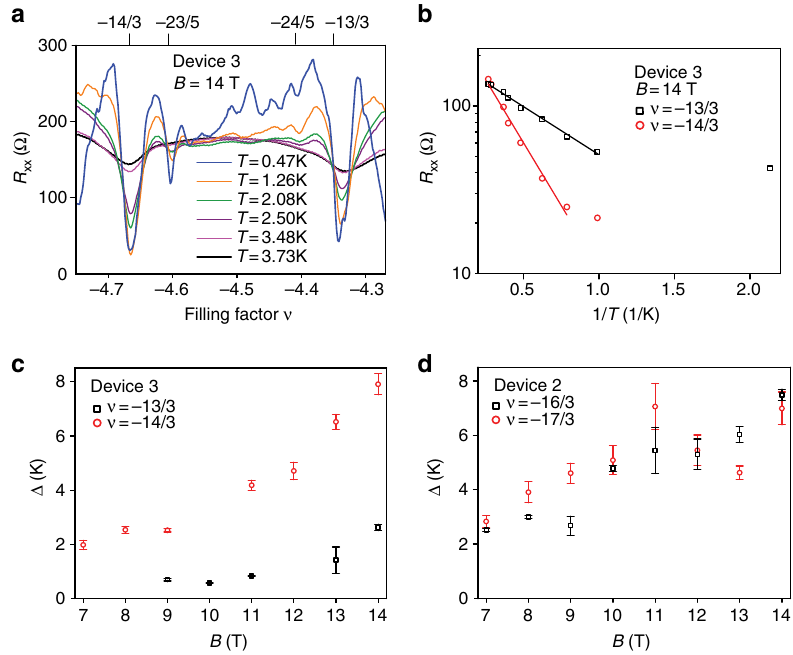
Figure 3 | Fractional quantum Hall gaps in the N ¼ 2 Landau level. ( a ) Temperature dependence of the magnetoresistance R xx for device 3 for (cid:2) 5 o n o (cid:2) 4 at 14T, showing that the R xx minima for the states with denominator 3 deepen with decreasing temperature down to B 1K. ( b ) R xx at n ¼ (cid:2) 13/3 and (cid:2) 14/3 (device 3) plotted on a semilogarithmic scale as a function of inverse temperature. The linear fits yield activation gaps, greater for n ¼ (cid:2) 14/3. The lowest temperature data points depart from activated behaviour, as is typically seen in QH systems at the onset of variable- range hopping and stronger localization. ( c ) Measured gaps as a function of magnetic field for n ¼ (cid:2) 13/3 and (cid:2) 14/3 (device 3) and ( d ) for n ¼ 16/3 and 17/3 (electron side in device 2). The error bars are due to the statistical error in fitting the data to the Arrhenius law R xx p e (cid:2) D /(2 T )